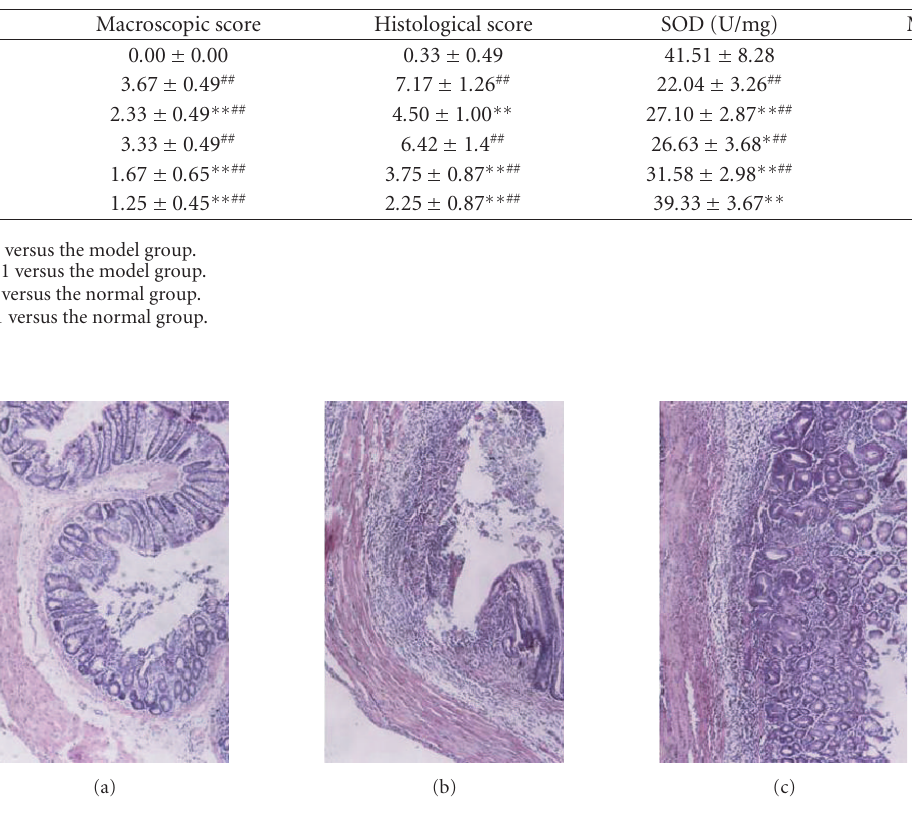
100); (b) the changes of histology with M (cid:2) (cid:2)